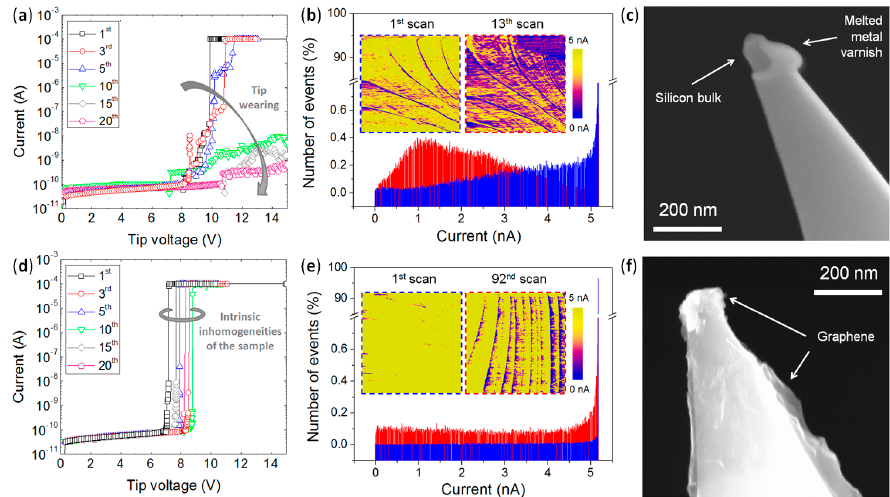
Figure 14. Reliability and durability test. Current vs. Voltage (I–V) curves performed on different positions of HfO 2 /Si stack by ( a ) uncoated AFM tip and ( d ) graphene coated tips. Reproduced with permission from [24], copyright Wiley-VCH (2013). Current spectra and the insets in ( b ) are the 1st (blue) and 13th (red) CAFM current maps collected on graphene/Cu foil with a standard metal-varnished nanoprobe. Current spectra and the insets in ( e ) are the 1st (blue) and 92th (red) CAFM current maps collected with a graphene coated nanoprobe. SEM images of AFM tips without ( c ) and with graphene coating ( f ) after testing. Reproduced with permission from [28], copyright The Royal Society of Chemistry